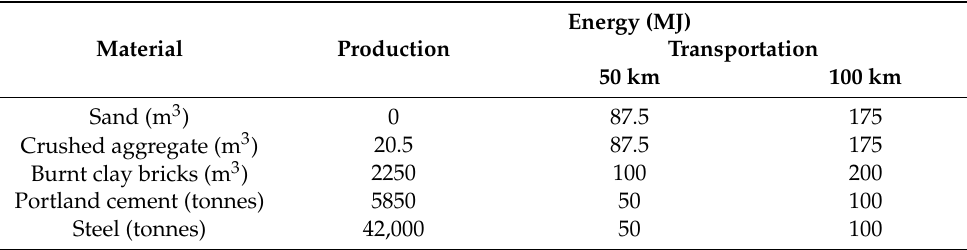
Table 2. Energy in the production and transportation of building materials (Reproduced from [30], the name of the publisher: